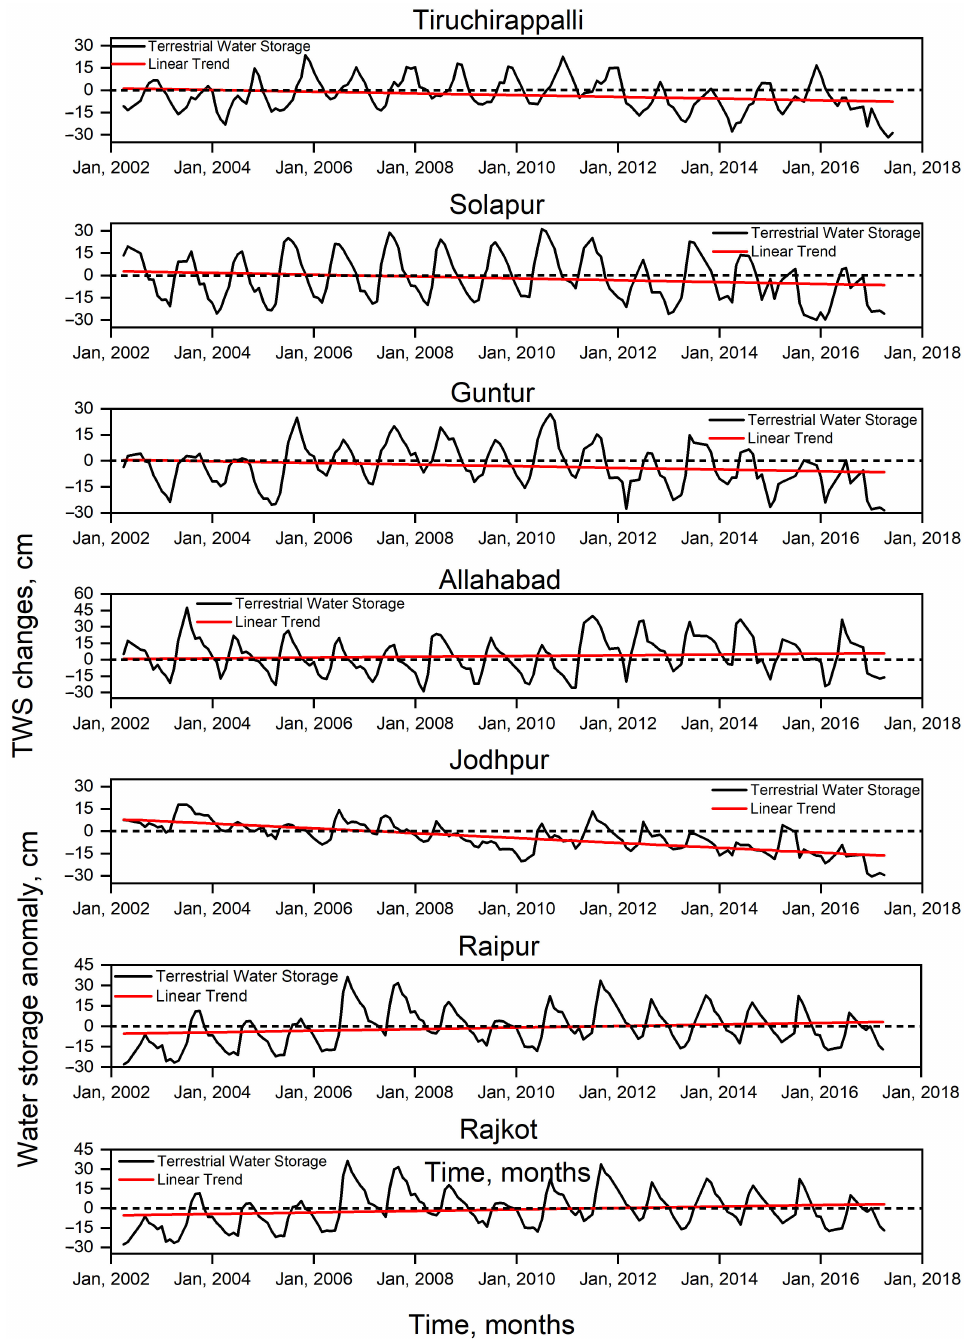
Figure A1. Terrestrial Water Storage (TWS) changes w.r.t time in the selected